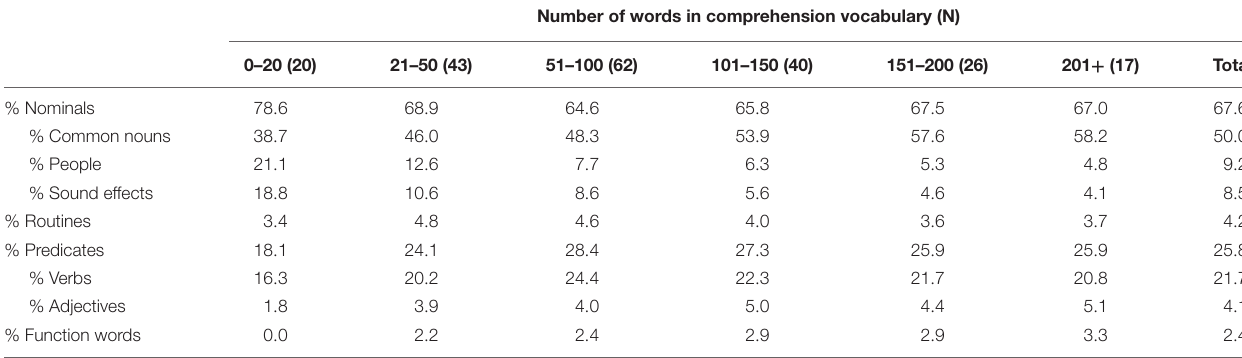
TABLE 6 | Categories of words in production vocabulary at different vocabulary sizes expressed as a proportion of chances to choose each category. Proportion of words on inventory